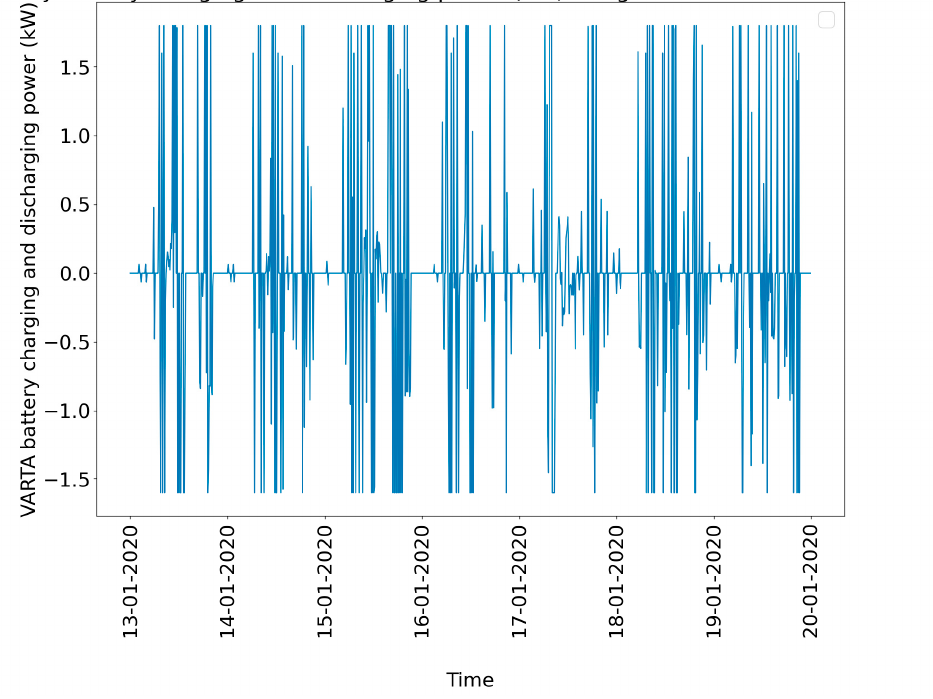
Figure A7. VARTA battery charging and discharging curve—January—Method 2.